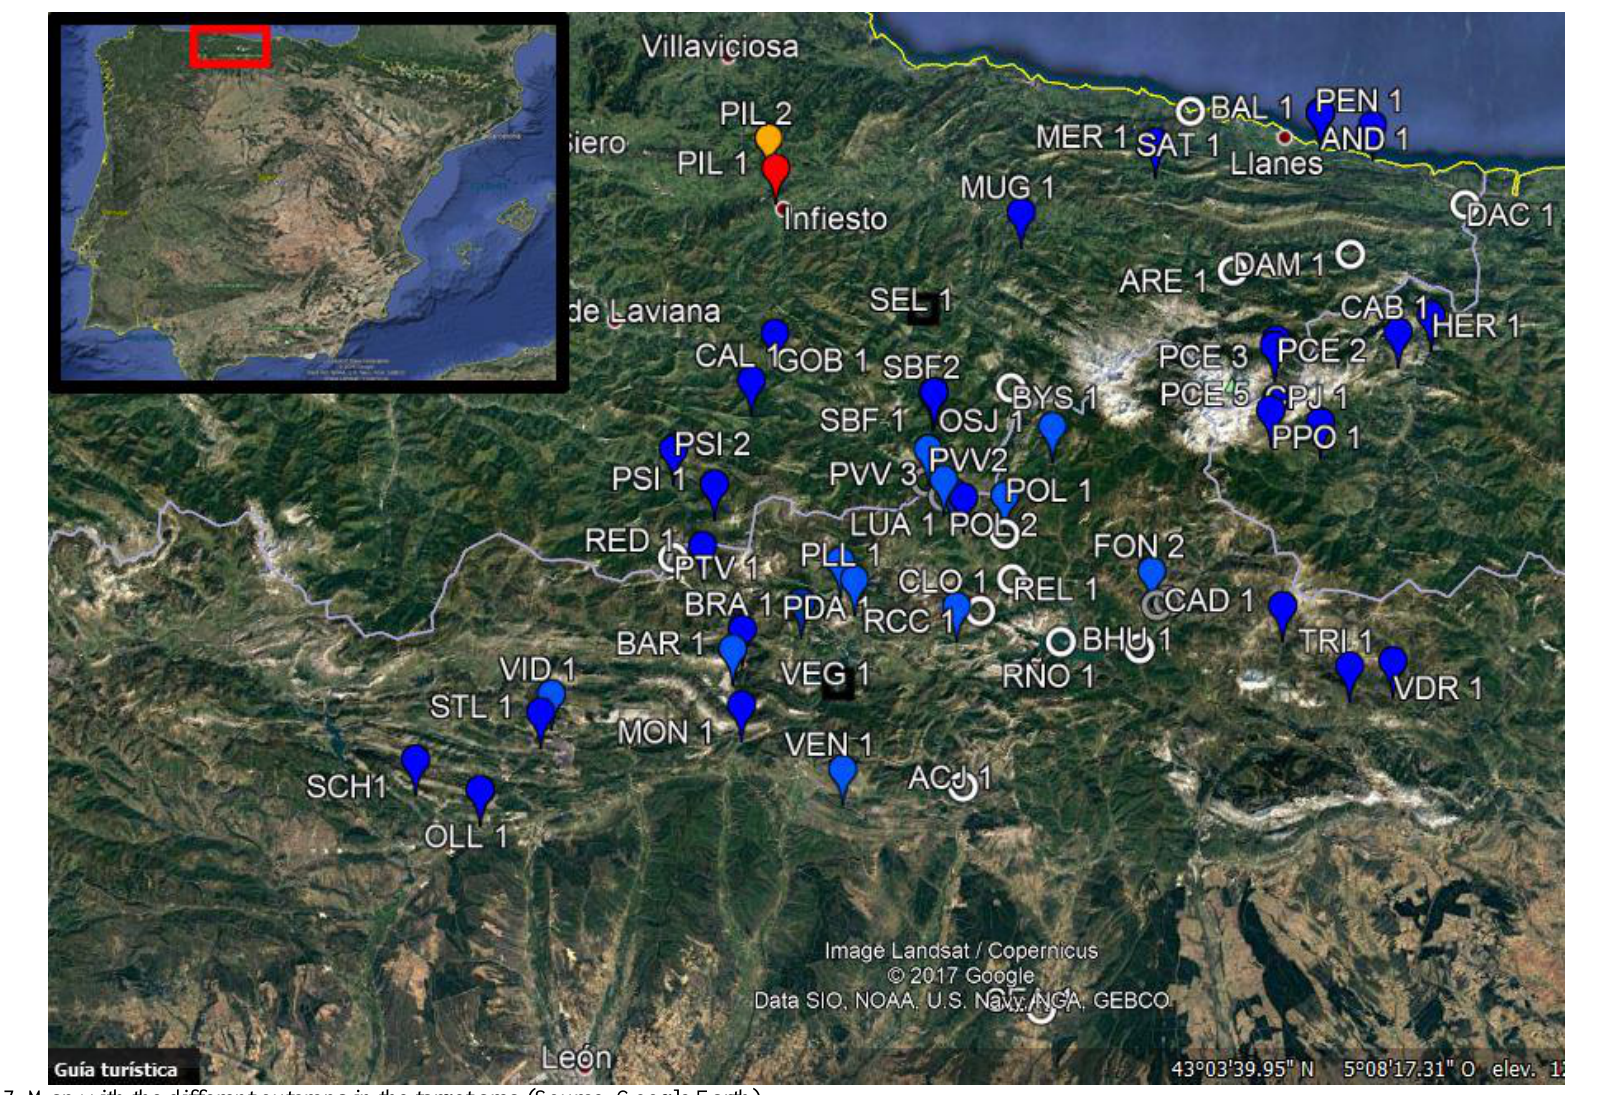
Figure 7: Map with the different outcrops in the target area (Source: Google Journal of Lithic Studies (2018) vol. 5, nr. 2, p. xx-xx DOI: https://doi.org/10.2218/jls.2926